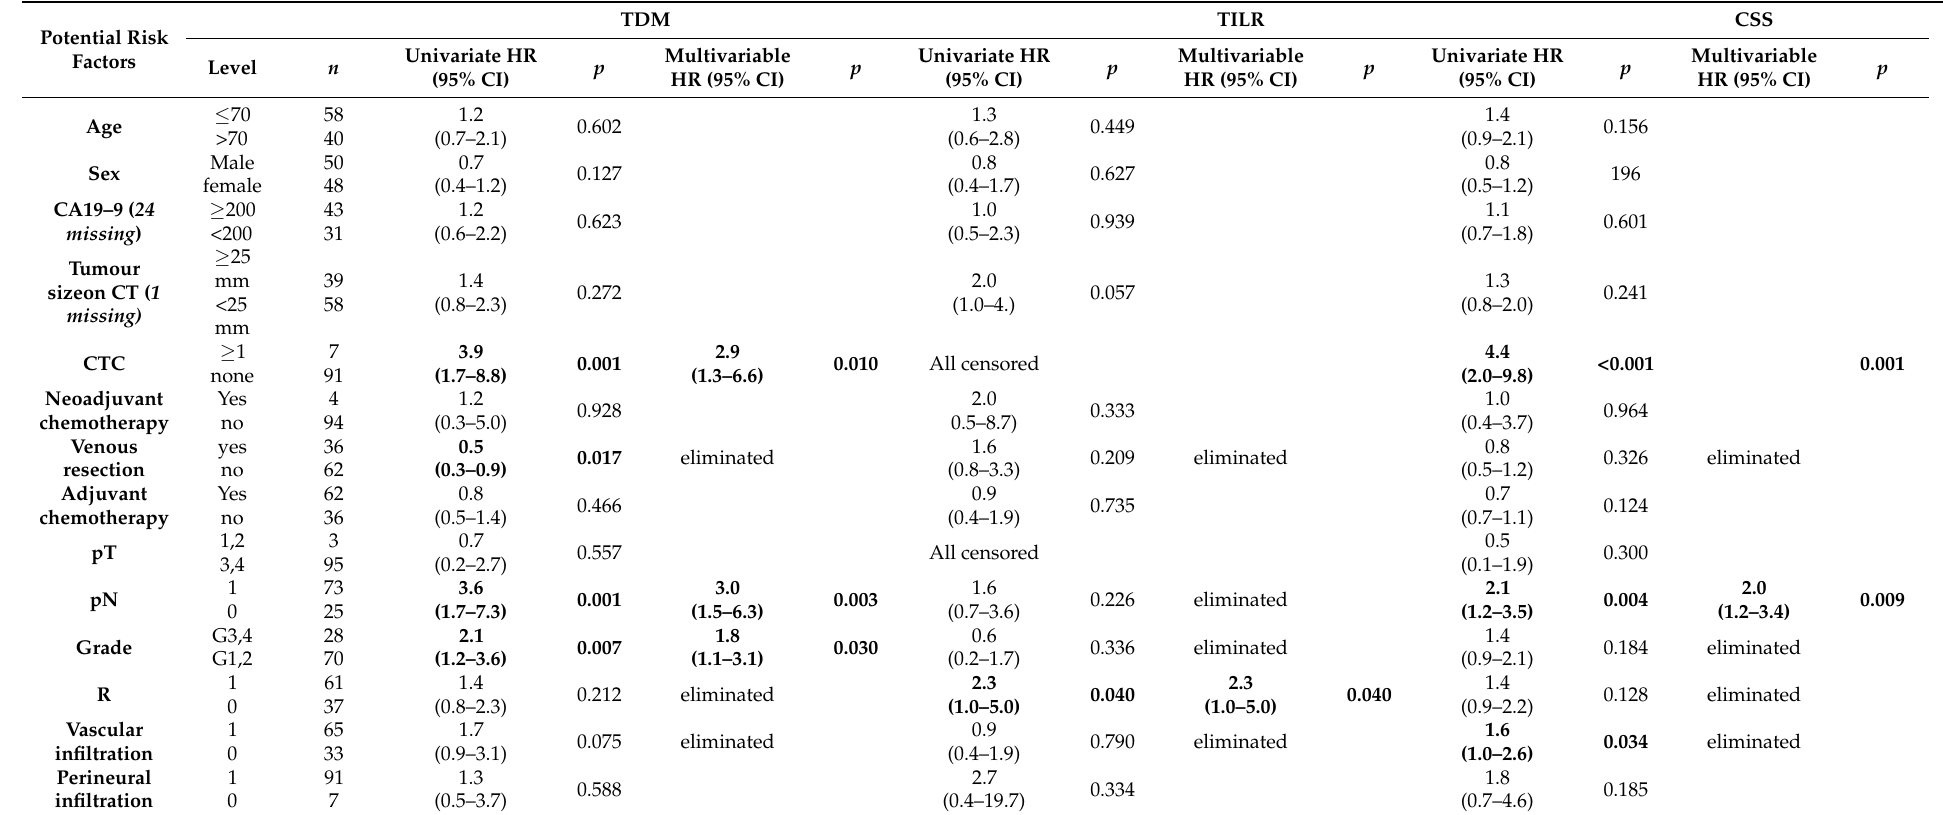
Table 2. Univariate and multivariable analyses of time to type of first recurrence and cancer specific